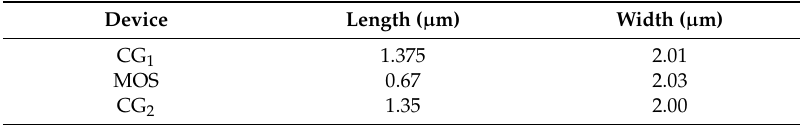
Table 1. The design parameters of the